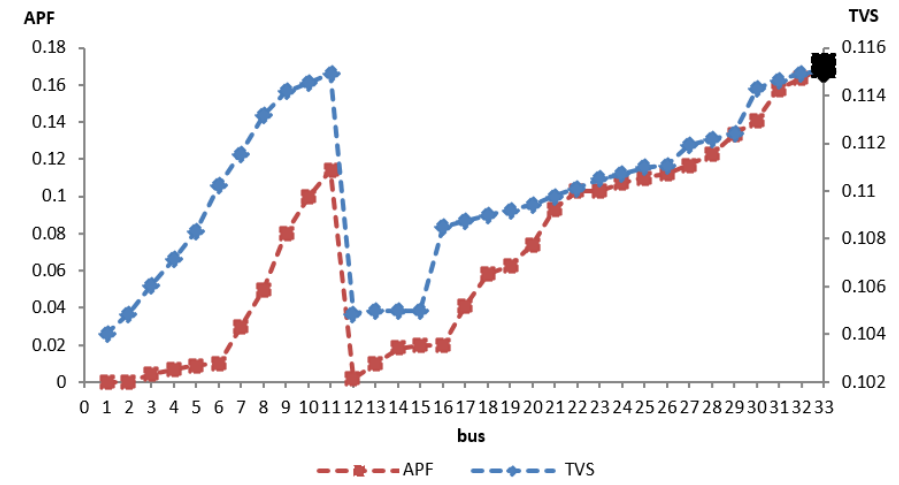
Figure 4. The APF and TVS for determining the second DER location.